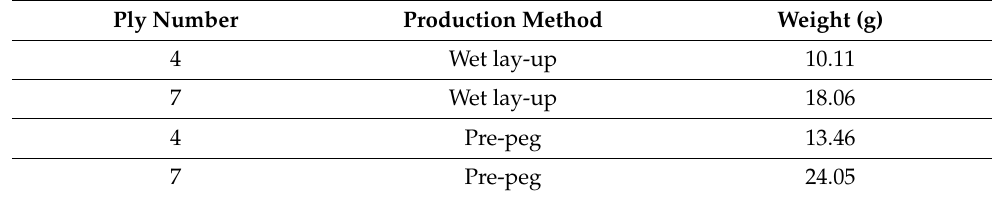
Table 3. Carbon fiber specimens’